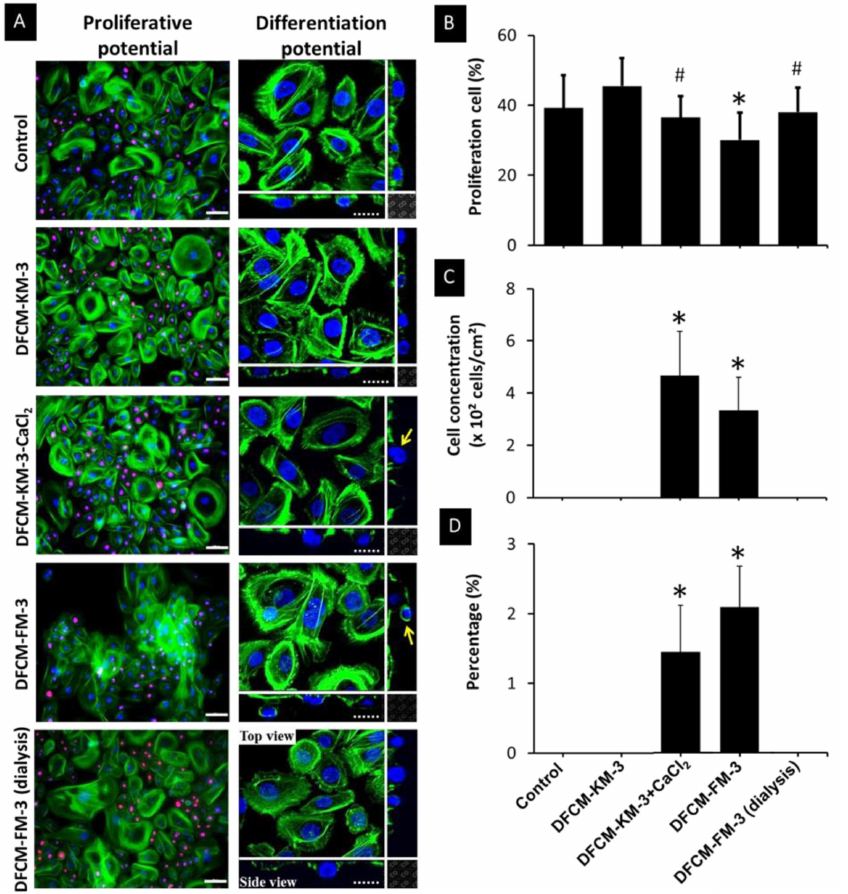
Figure 5. Effect of calcium in DFCM on keratinocyte proliferation and multilayer formation. ( A ) Repre- sentative images of actin (green), DAPI (blue) and Ki67 (red) expression by keratinocytes under different culture conditions. Arrow shows cells that formed multilayer. Scale bar: 100 µ m. ( B ) Percentage of proliferating cells under different culture conditions. Here, * indicates significantly lower compared to control and other conditions; # indicates significantly lower compared to DFCM-KM − 3 ( p ≤ 0.05). ( C ) Cell concentration and ( D ) percentage of keratinocytes that formed a multilayer under different culture conditions. Here, * indicates significantly higher compared to other conditions ( p ≤